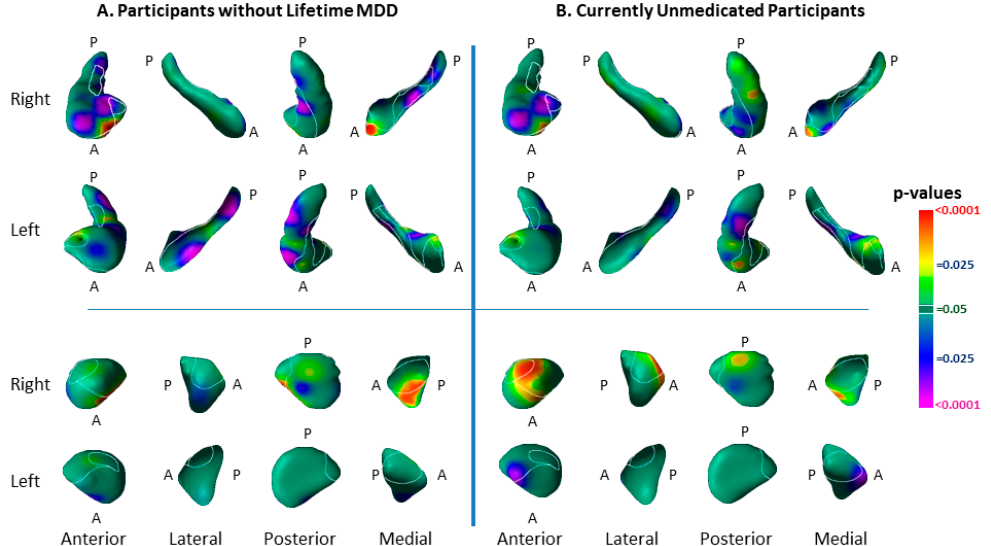
Figure 4. Risk-group Effect Distinct from the Effect of Lifetime Major Depressive Disorder and Medication Use. Panel ( A ): The risk-group effect (32 HR vs. 55 LR) is shown when excluding all participants who had a lifetime history of MDD. Findings for the hippocampus are very similar to the effects when including all participants (Figure 1 of the main text), demonstrating that the surface morphological features for that structure are genuine risk effects, as they are detected in offspring of persons with MDD but who, themselves, have never had depressive illness. Many of the findings in the amygdala shown in Figure 1 of the main text, however, are not statistically significant in this subgroup analysis, either because those effects derive from the effects of lifetime MDD or because of the reduced statistical power in this analysis because of the smaller numbers of participants in this subgroup analysis. Panel ( B ): The risk-group effect (57 HR vs. 59 LR) is shown when excluding all participants who were taking psychotropic medications at the time of MRI scanning. The effect of risk group is similar to the effects detected when including all participants (Figure 1). These findings demonstrate that the risk effects reported Figure 1 are independent of medication effects. The statistical models included the main effect of risk group, and the covariates of age, age 2 , and sex. p -values are thresholded at p = 0.05 after FDR correction for multiple comparisons . Table 4. Psychotropic Medication Use at the Time of MRI Scanning .